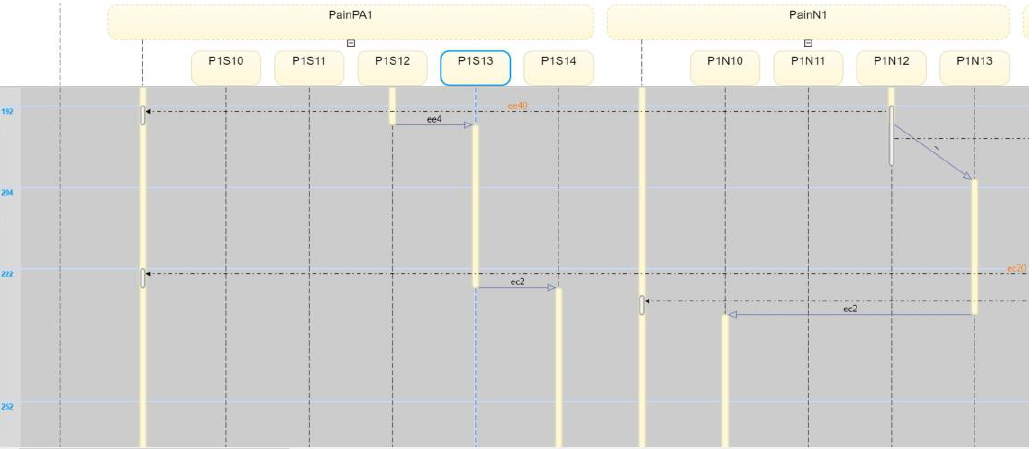
Figure 22. The 𝑷𝑨 𝟏𝒐 automaton interacts with the care provider regarding the pain symptom via time-stamped coupling events. This view also shows the hospitalist behavior, namely, the coupling event 𝒄 𝟐 (or ec2).